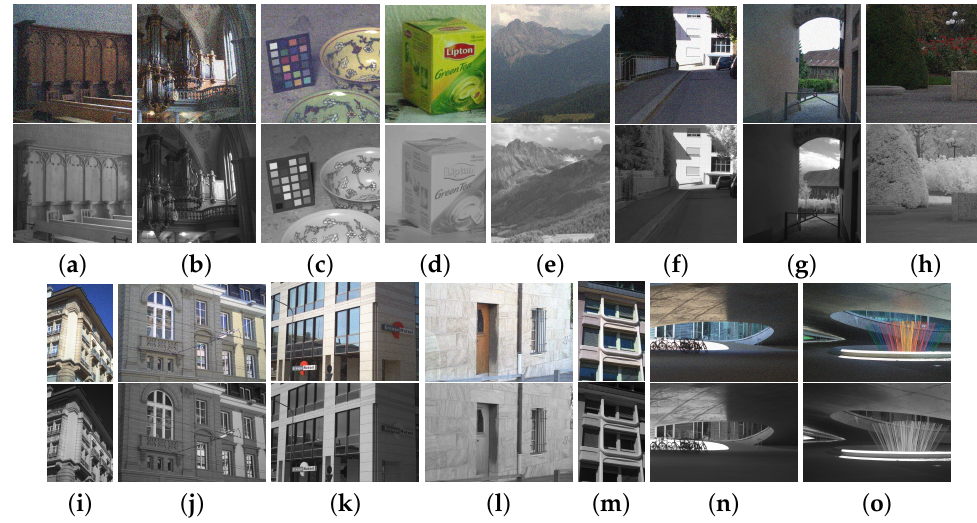
Figure 8. Test image pairs with noisy RGB images ( top ) and NIR images ( bottom